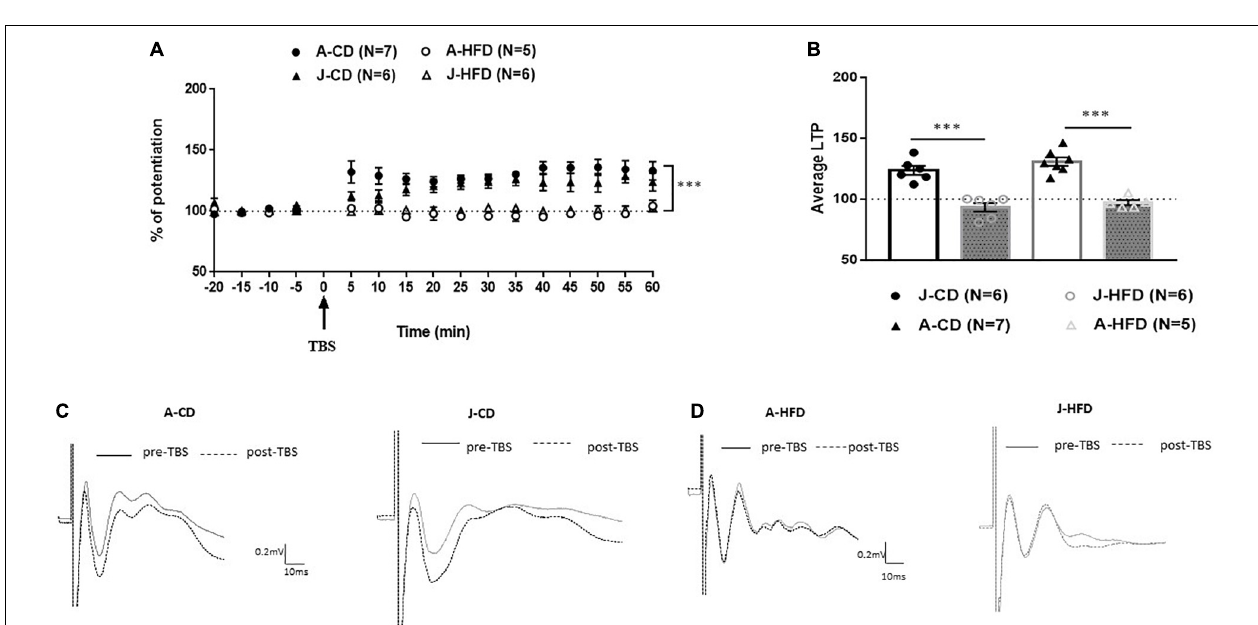
FIGURE 3 | Effect of 7-day HFD exposure on prefrontal long-term potentiation (LTP) in juvenile and adult animals. Electrophysiological recordings were performed on juvenile (PND 28) and adult (PND 67) animals immediately after completing a 7-day HFD or CD regimen. (A) Normalized field excitatory post-synaptic potentials (fEPSPs) recorded in vivo before and after TBS of the BLA-mPFC pathway. Each data point shows the average fEPSPs of the preceding 5 min. (B) Average LTP shown in panel A over the 60 min after TBS. (C,D) Representative average waveforms before and after TBS Horizontal bar = 10 ms; vertical bar = 0.2 mV. Overall: HFD was shown to impair LTP in juveniles and adults: Two-way ANOVA with repeated measures on the 12 post-TBS time points showed a significant effect for Diet ( ∗∗∗ p < 0.001) without a significant effect of Age × Diet interaction. Error bars show standard error of the mean (SEM).